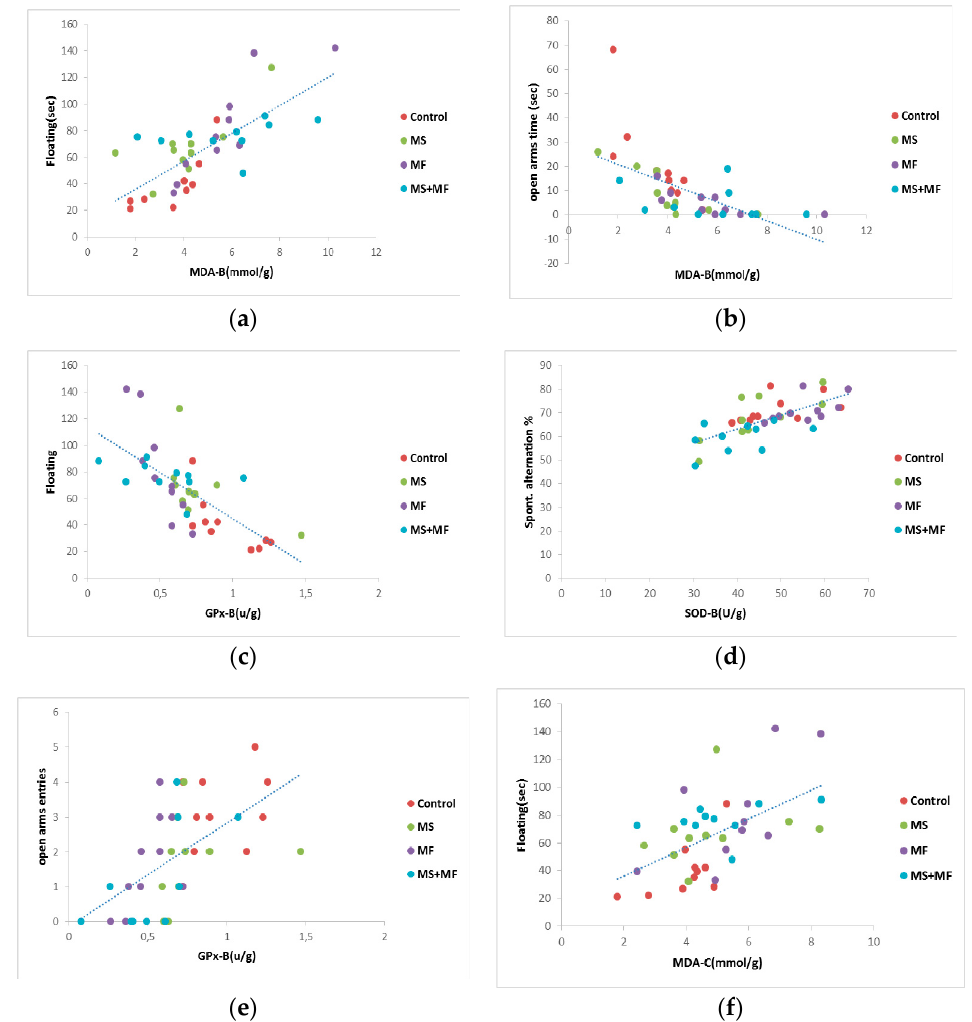
Figure 9. Statistical correlations between behavioral parameters: ( a ) floating duration vs. MDA brain levels, ( b ) open arms time vs. MDA brain levels, ( c ) floating vs. brain GPx activity, ( d ) spontaneous alternation vs. brain SOD activity, ( e ) open arms entries vs. brain GPx activity, ( f ) floating and bowel MDA levels ( n = 40, OAT = open arms time, OAE = open arms entries, MDA-B = MDA brain level, SOD-B = brain activity of SOD, GPx-B = activity of brain GPx, MDA-C = colon MDA level).